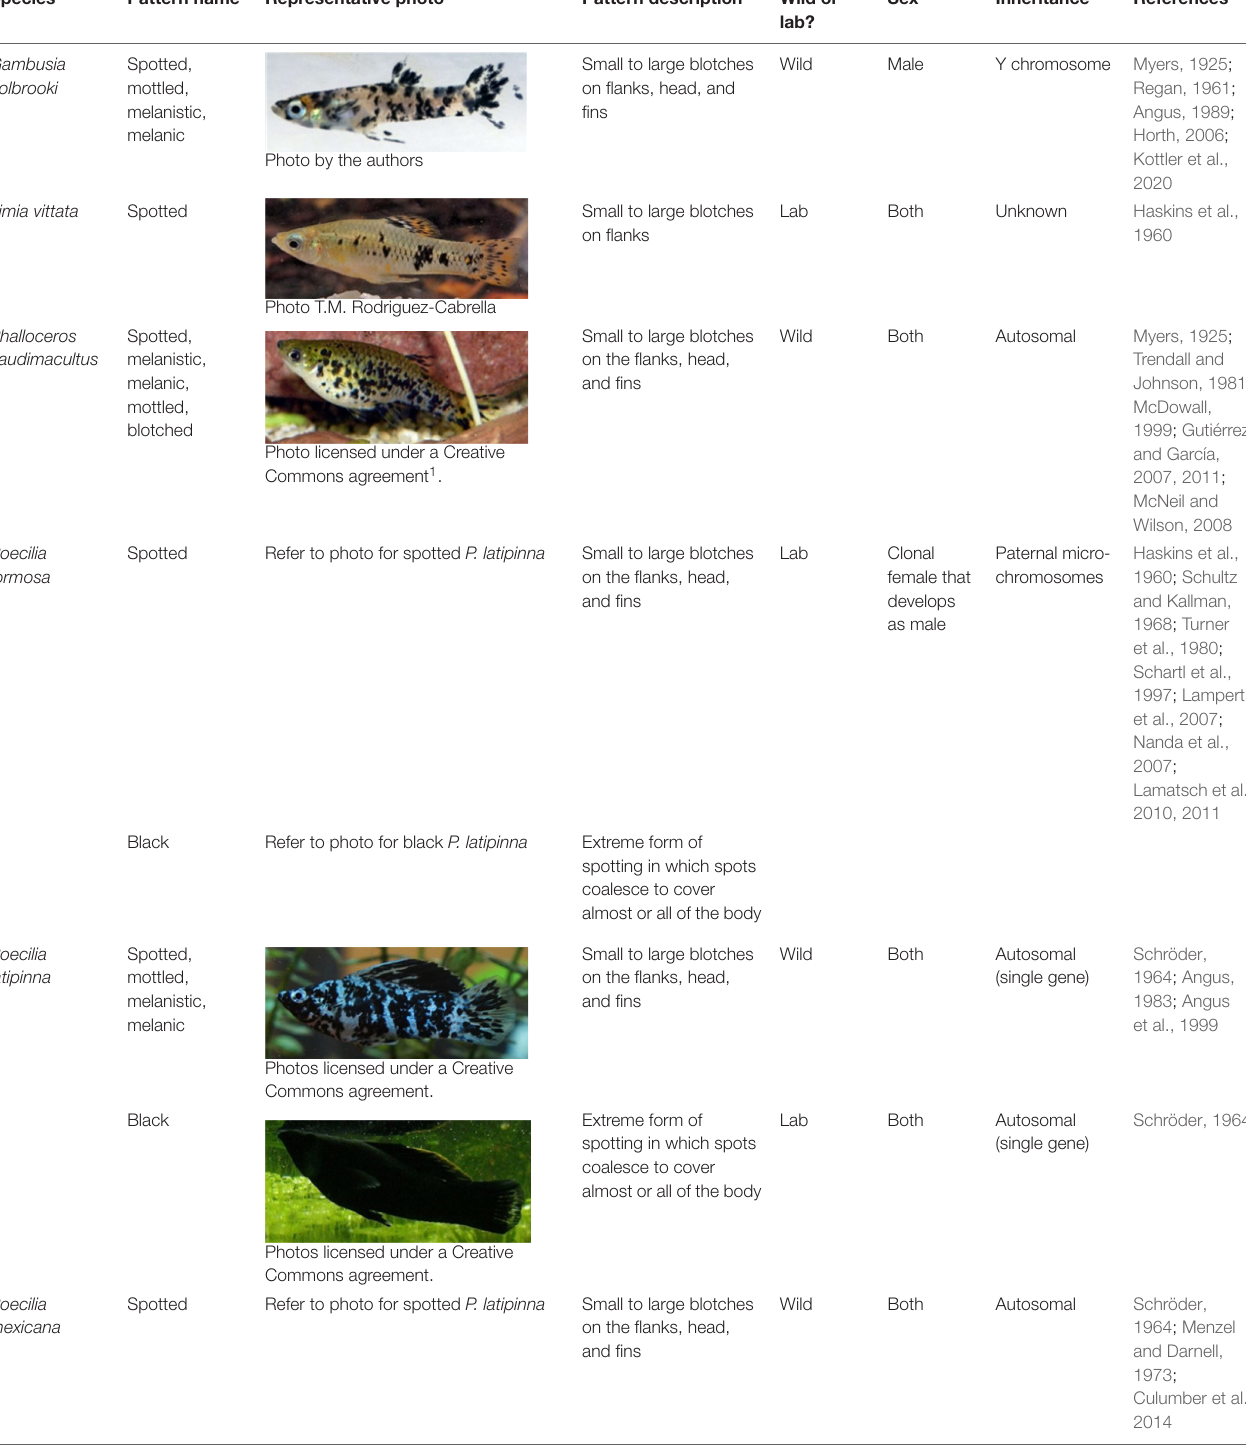
TABLE 1 | Summary of the specific poeciliid pigmentation patterns included under the “melanic side-spotting pattern” definition of this review.